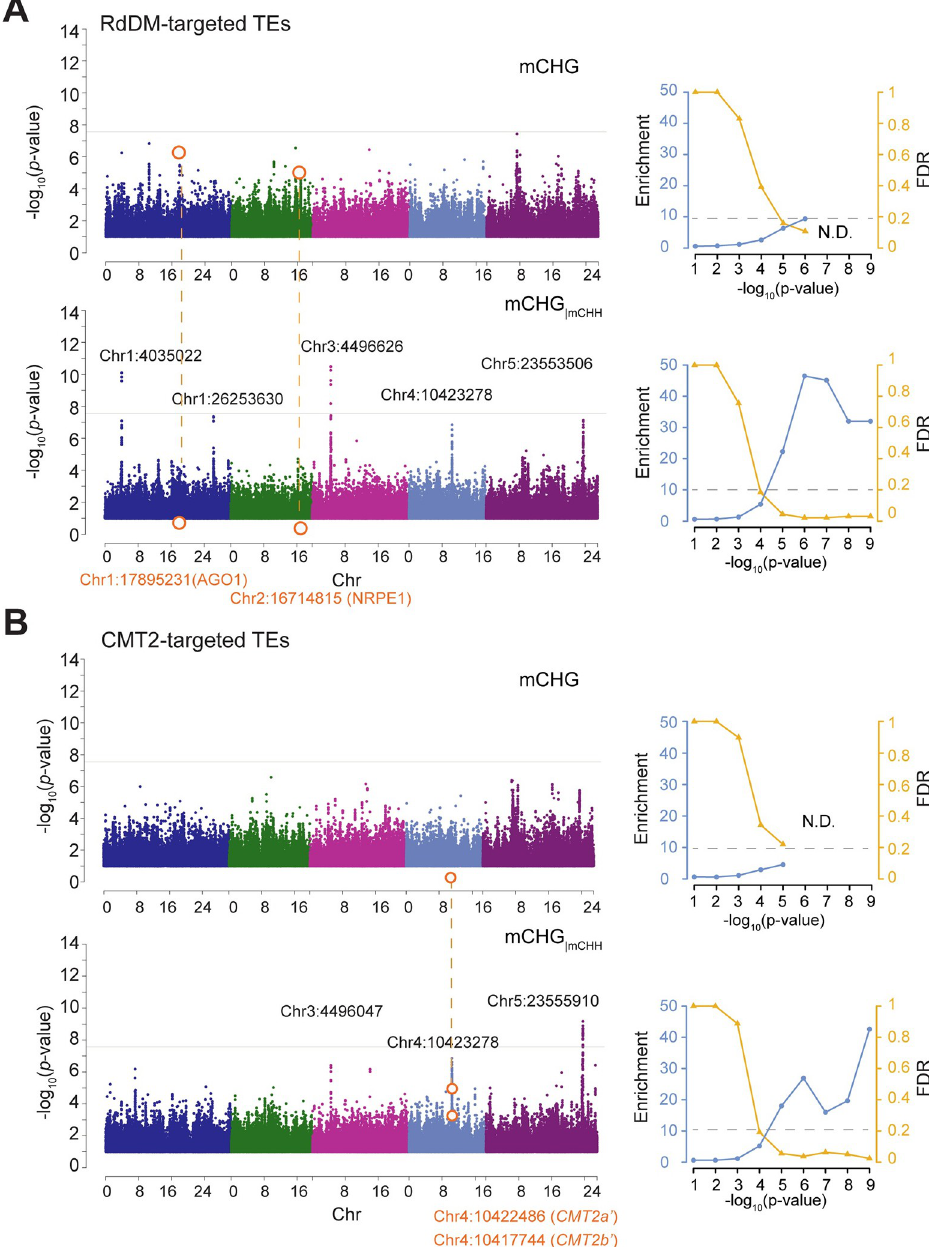
Fig 2. Comparison of univariate and conditional GWAS of mCHG. The analysis was done separately for ( A) RdDM-targeted and ( B ) CMT2-targeted transposons, using the 774 lines in the global panel from the 1001 Epigenomes Project (“SALK leaf in ambient temperature”; see Fig 1). For each case, the upper Manhattan plot shows univariate GWAS of mCHG and the lower GWAS of mCHG controlling for mCHH. Horizontal gray lines show genome-wide significance ( p = 0.05 after Bonferroni-correction). The line plots show enrichment of a priori genes and FDR (see text), with horizontal dashed lines indicating an FDR of 20%. FDR of 20%, univariate GWAS of mCHG identifies only AGO1 and NRPE1 for RdDM-tar- geted transposons, and nothing for CMT2-targeted transposons (S2 Table), whereas condi- generates a long list of known regulators of mCHG (S2 Table). tional GWAS of mCHG |mCHH